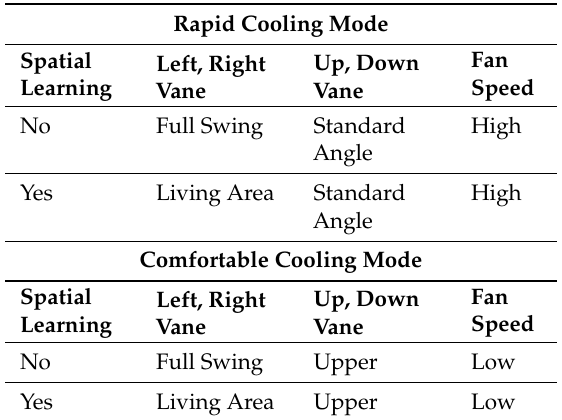
Table 1. Control of air conditioning operation with and without spatial learning